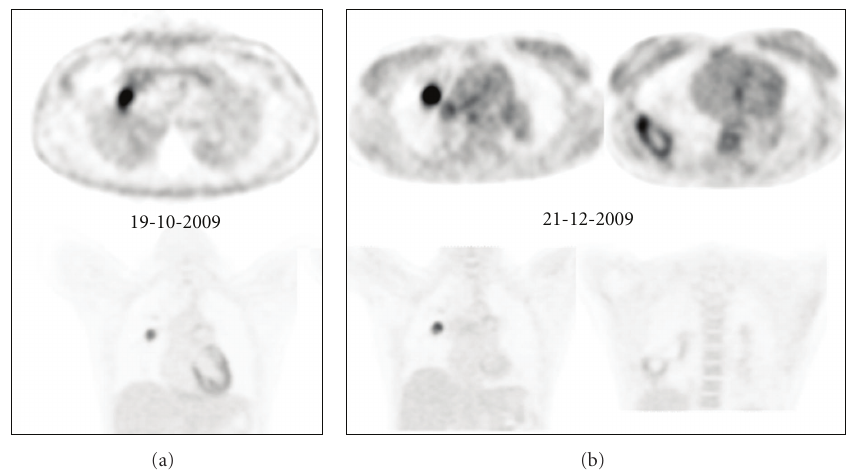
Figure 2: (a) Initial PET scan. Metabolic active lesions in the right upper lobe which diameter increased over time, with appearance of a metabolically active cavity in the right lower lobe. (b) Follow-up PET scan after 2 months of oral corticosteroids. The diameter of the metabolic active lesions in the right upper lobe increased over time, with appearance of a metabolically active cavity in the right lower lobe.